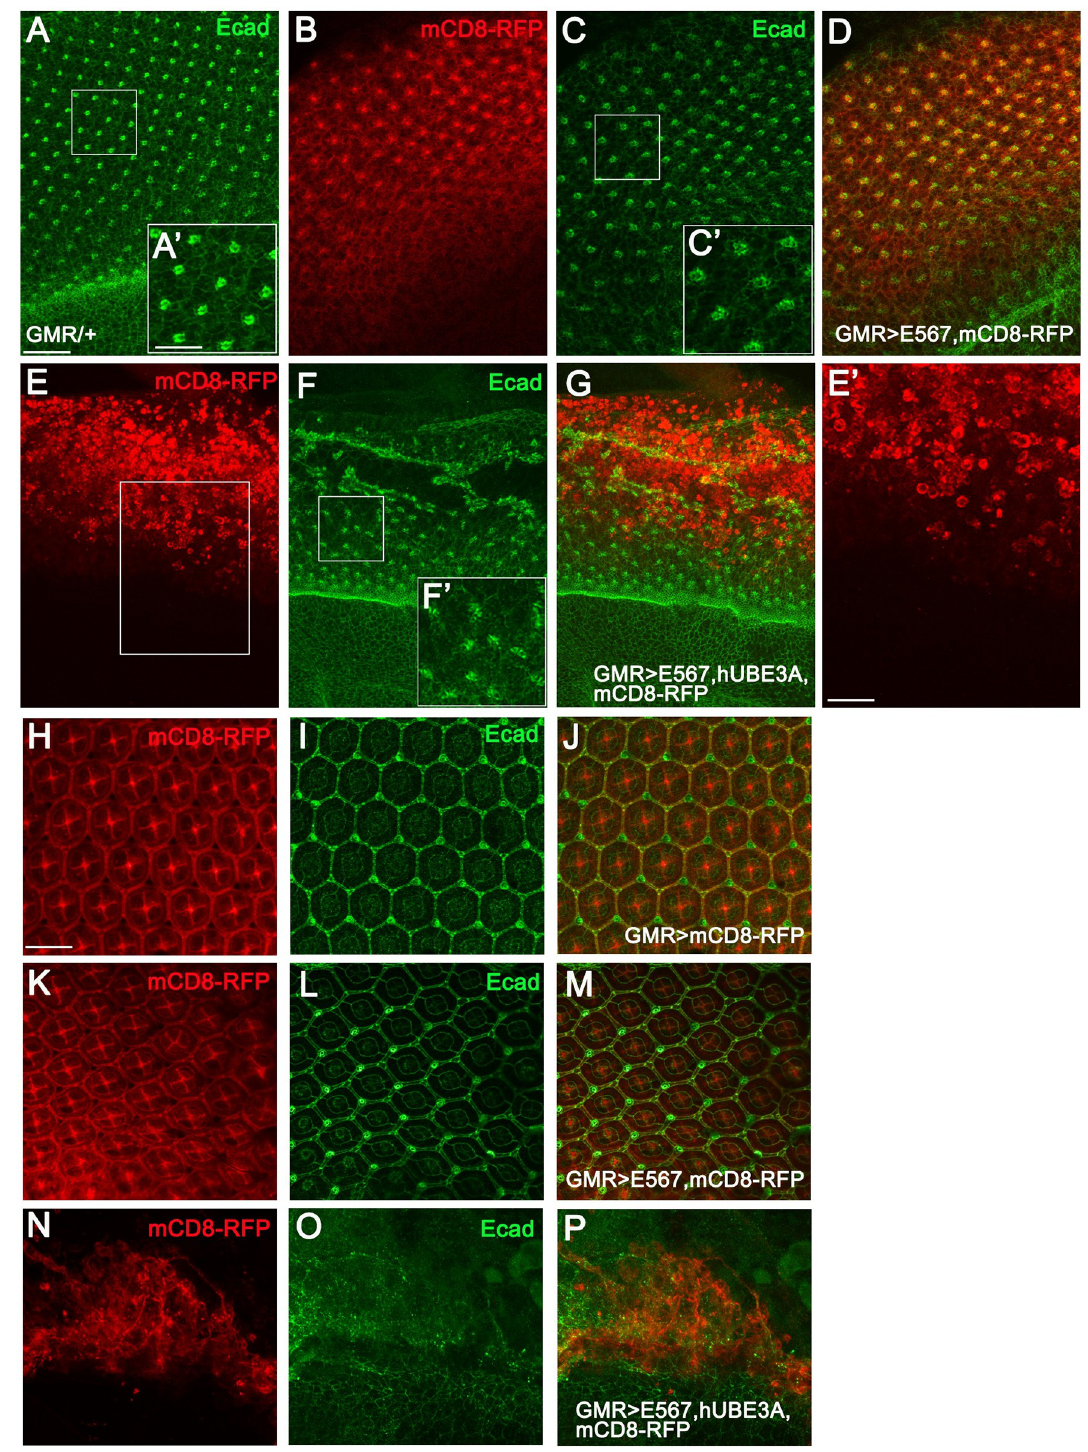
Fig 2. HPV16 E5, E6, E7 oncoproteins disrupt epithelial integrity. Transgenes were expressed in the third instar larval eye discs ( A-E’) and in pupal eyes 42 hours after pupation (H-P), using GMR-Gal4. Tissues were immunolabelled for adherens junction protein, E-cad and the expression of mCD8RFP was used to mark the area of transgenes expression. (A) GMR-Gal4-expressing eye disc showing an intact epithelium with proper localization of E-cad (A’) and a sequential pattern of differentiated ommatidia. (B-D) Co- expression of HPV16 E5, E6, E7 and the membrane marker, mCD8RFP showing no cellular abnormalities as indicated by proper